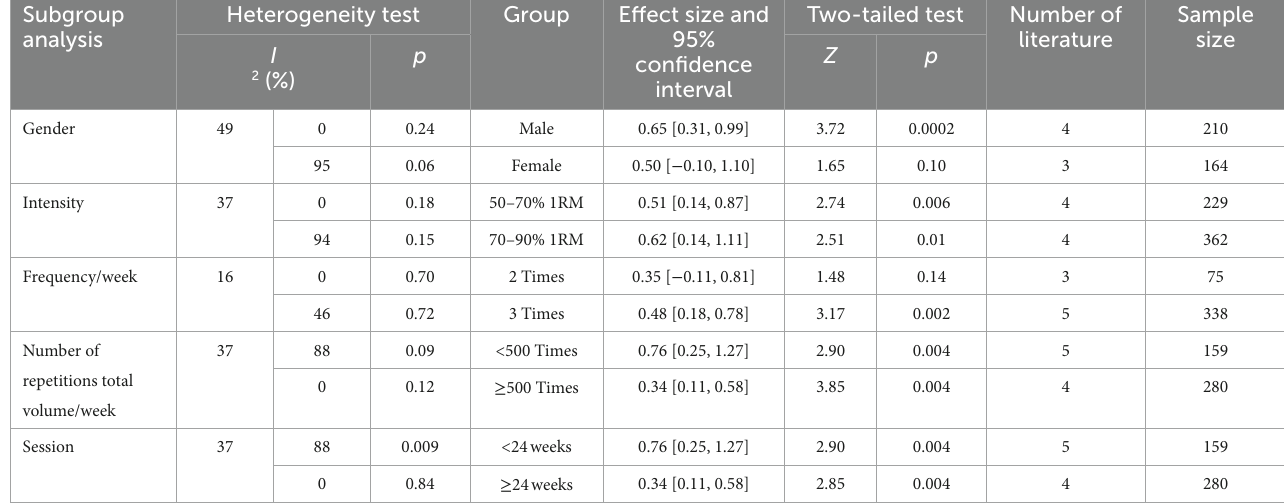
TABLE 3 Results of subgroup analysis on lower extremity muscular strength. Subgroup